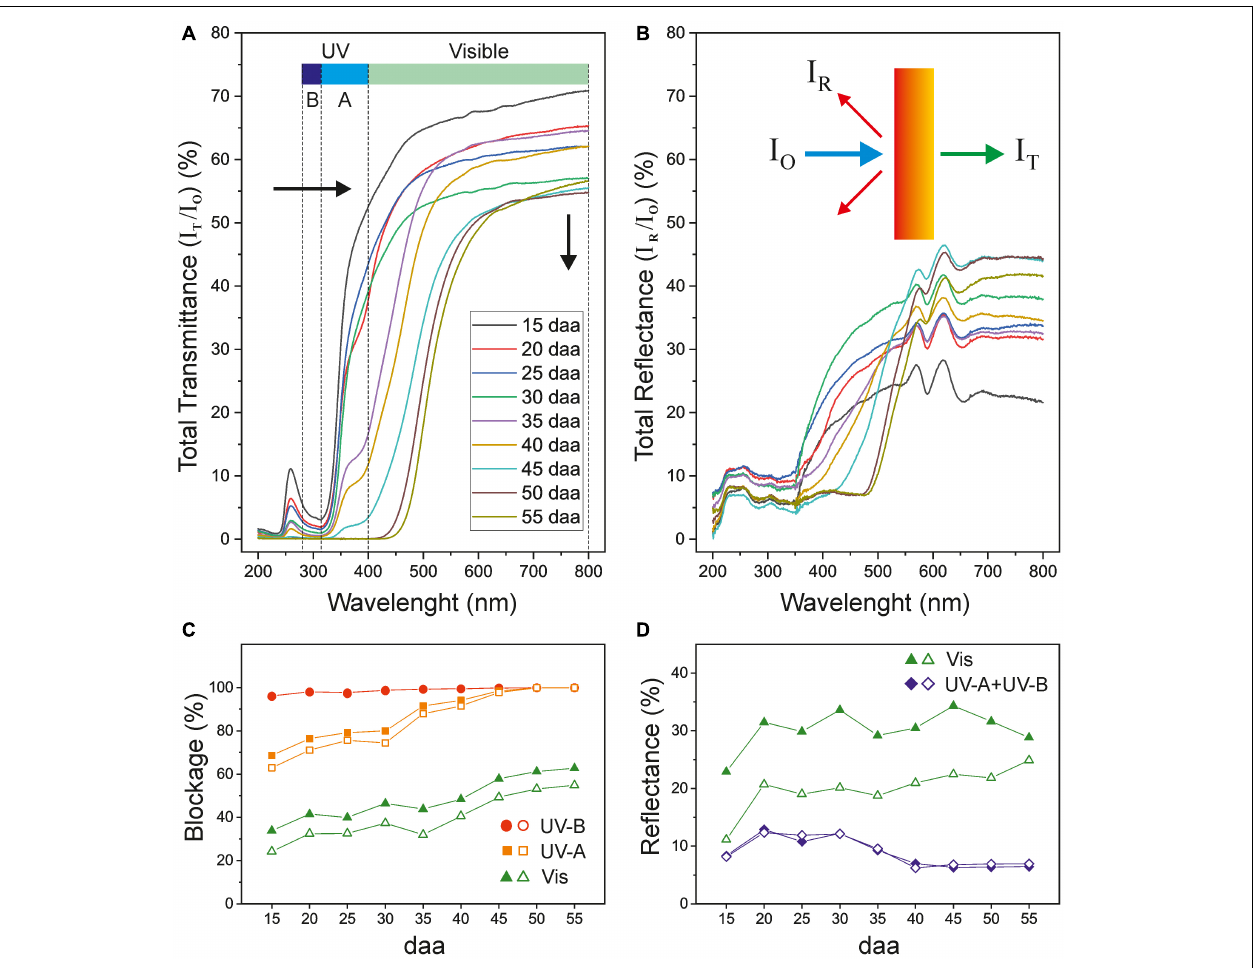
FIGURE 7 | (A) Total transmittance and (B) total reflectance spectra of isolated tomato CMs along fruit growth and ripening. Black arrows in (A) show the spectra displacement along fruit development. (C) Blockage and (D) reflectance percentages of UV and visible light of tomato fruit cuticle membranes during growth and ripening. Open symbols correspond to dewaxed